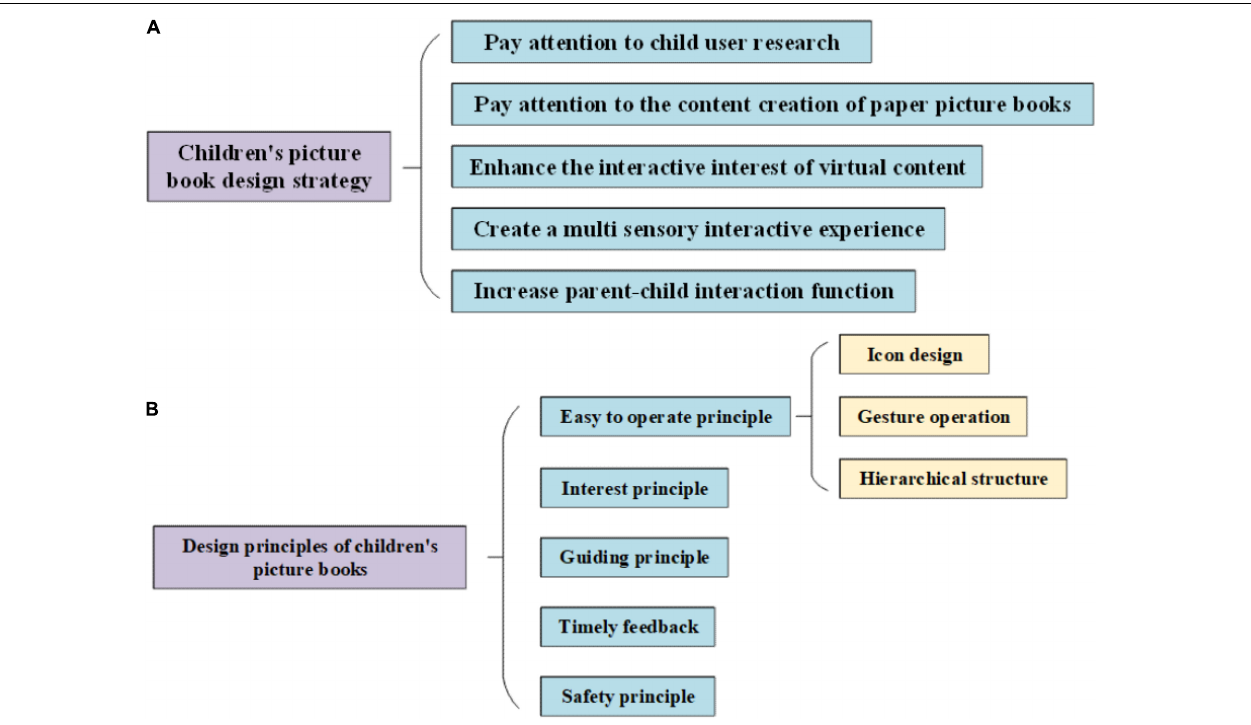
FIGURE 11 | Design method of AR picture book based on the mobile terminal. (A) Children’s picture book design strategy. (B) Interactive design principles of children’s picture